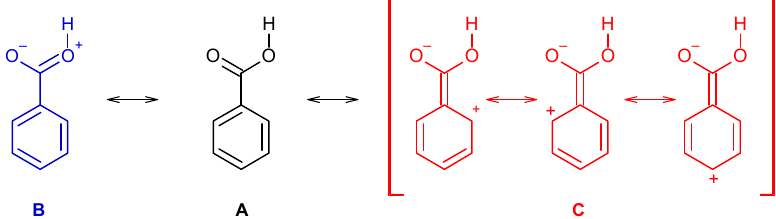
Scheme 1. Mesomeric structures representing the resonance stabilization within the carboxylic group ( B ) and the competing cross conjugation with the aromatic ring ( C ). Structure A corresponds to the molecule canonical form.